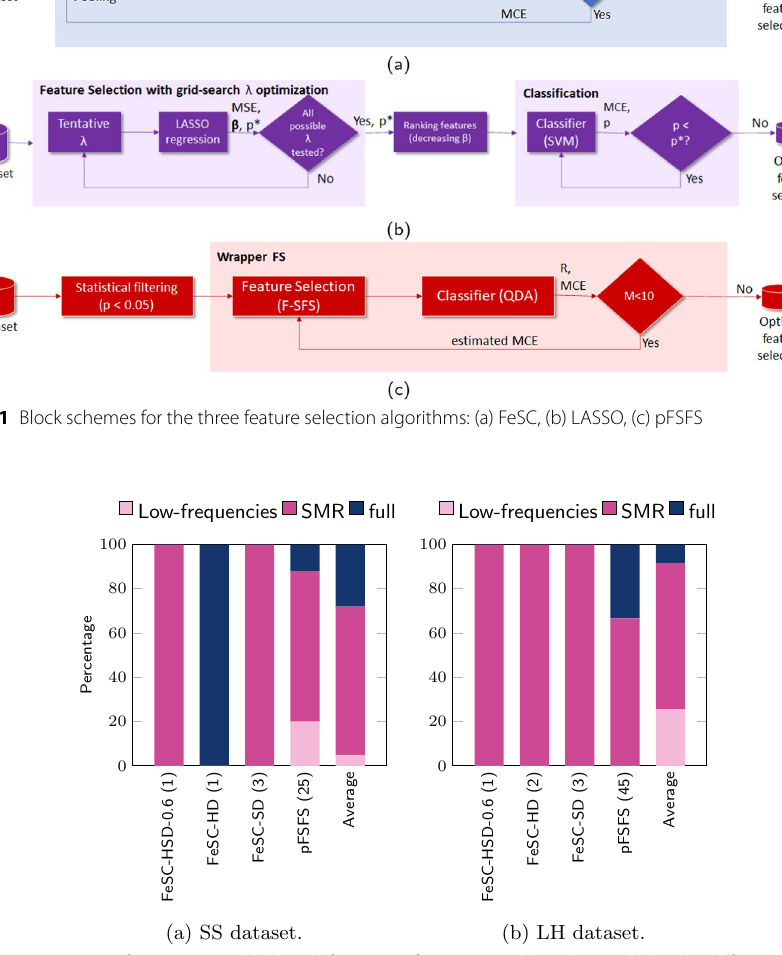
Fig. 2 Percentage of iterations in which each frequency feature was selected as stable by the different algorithms (threshold was set to 70%). To note, algorithms were sorted by the increasing number of stable